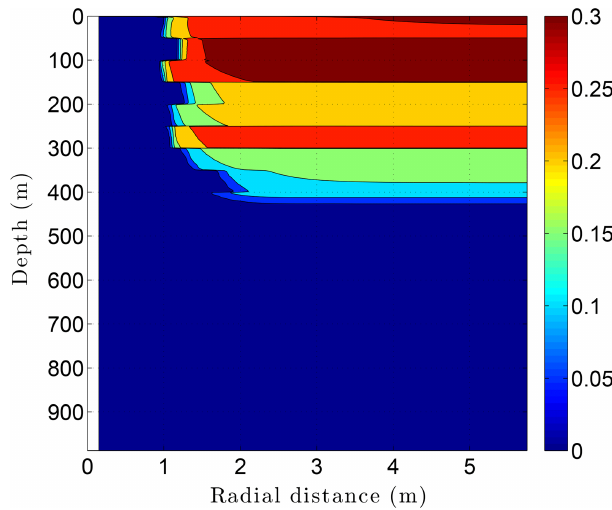
Figure 14. Volumetric ice content φ i in the sedimentary sequence (Fig. 8) penetrated by a newly completed 3km deep borehole (day 60). Radial distance is measured from the central axis of the borehole.